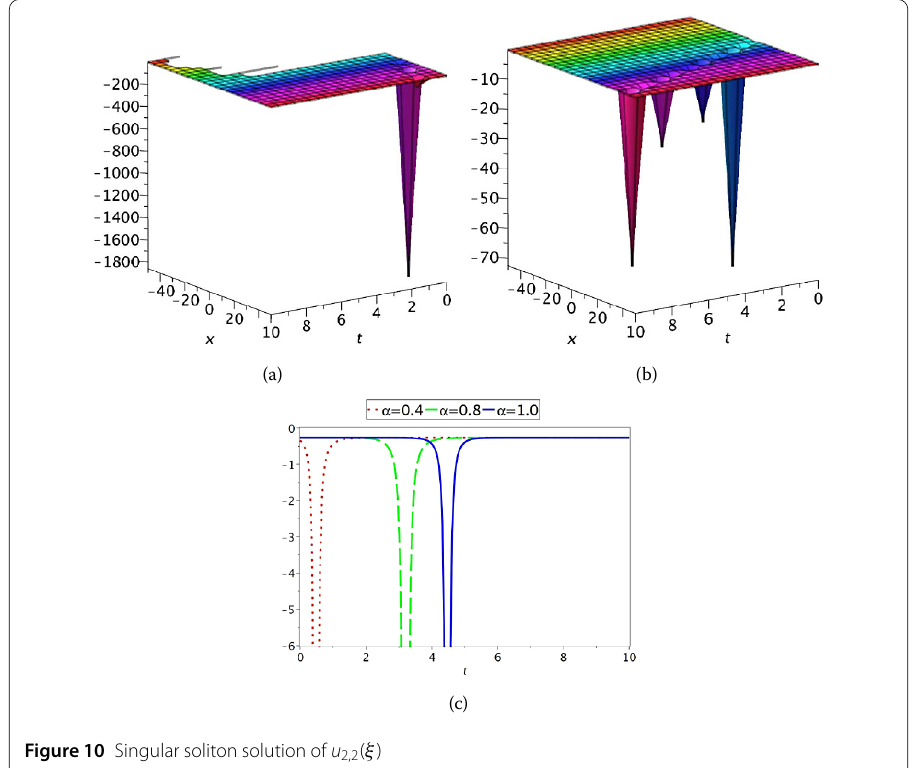
Figure 10 Singular soliton solution of u 2,2 ( ξ )